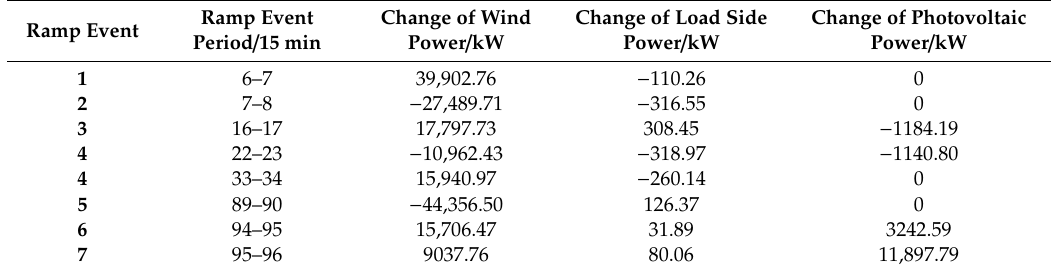
Figure 7. The occurrence of wind power ramp events in grid 1.